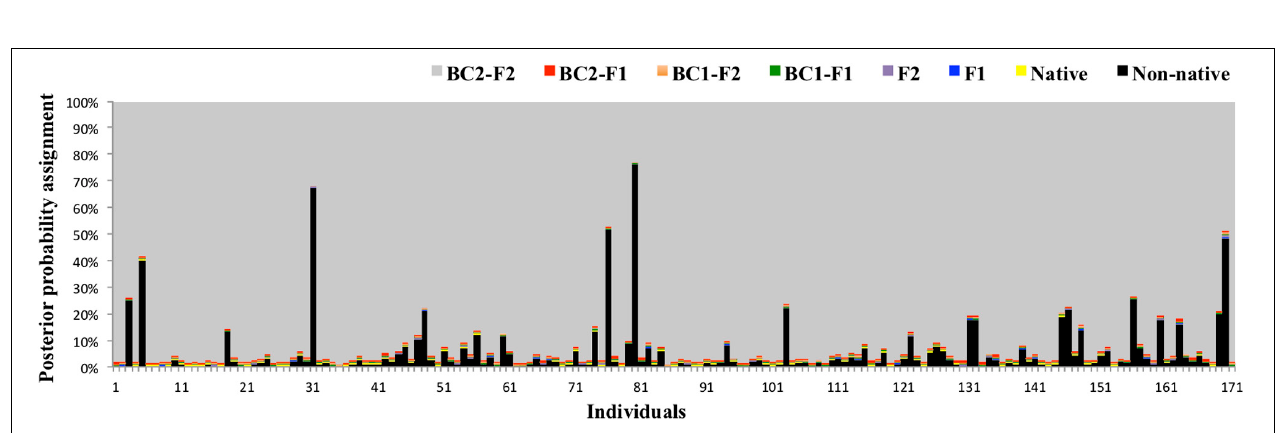
FIGURE 5 | Posterior probability assignment values obtained in NEWHYBRIDS for the 171 individuals identified as hybrids in STRUCTURE. Genotype classes are represented by different colors: native (yellow), non-native (black), F1 (blue), F2 (purple), F1 backcross with native (BC1-F1, green), F2 backcross with native (BC1-F2, orange), BC1-F1 backcross with native (BC2-F1, red) and BC1-F2 backcross with native (BC2-F2, gray).